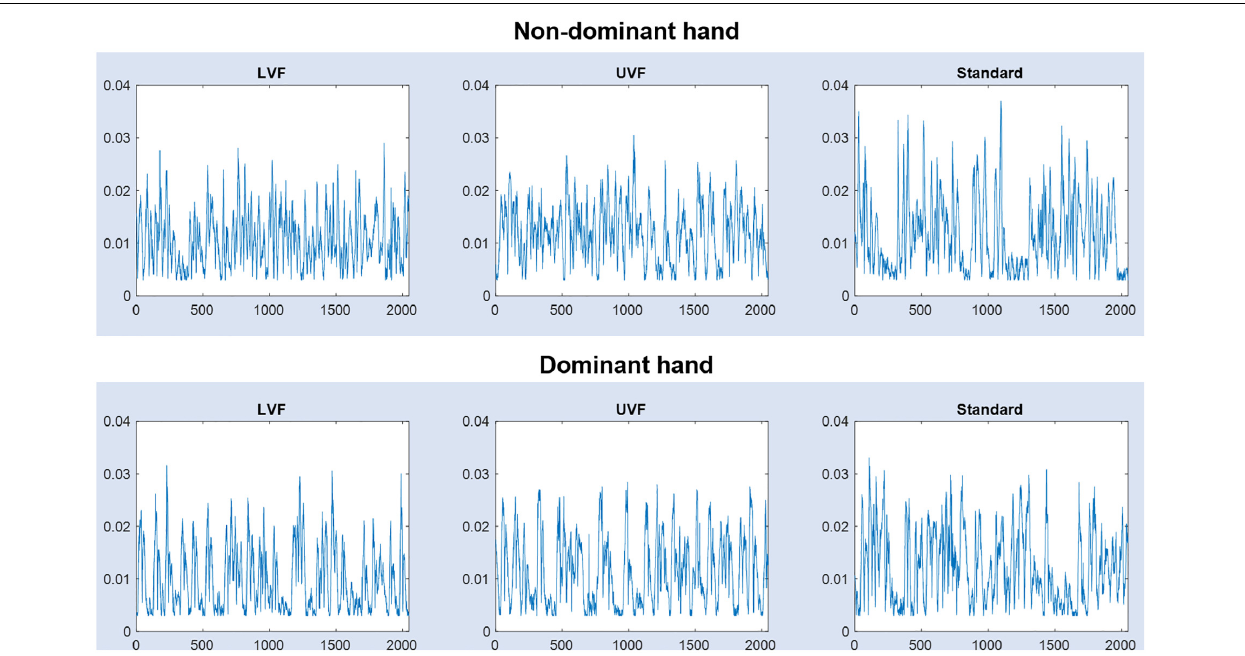
FIGURE 2 | Hand movement signals (interpoint distance in meters vs. time) from one subject, in the three conditions [lower view field (LVF), upper view Field (UVF) and Standard], for the dominant and non-dominant hands.